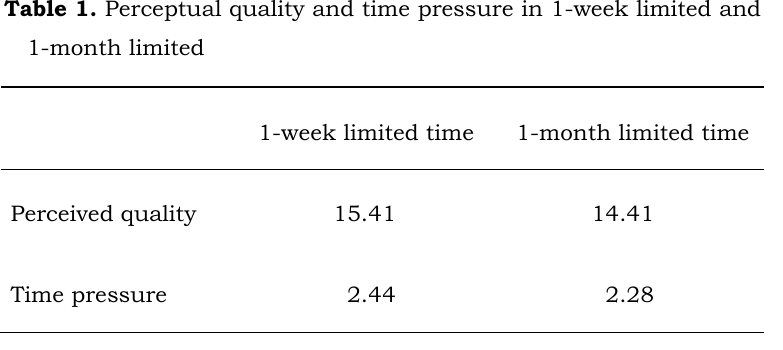
Table 1. Perceptual quality and time pressure in 1-week limited